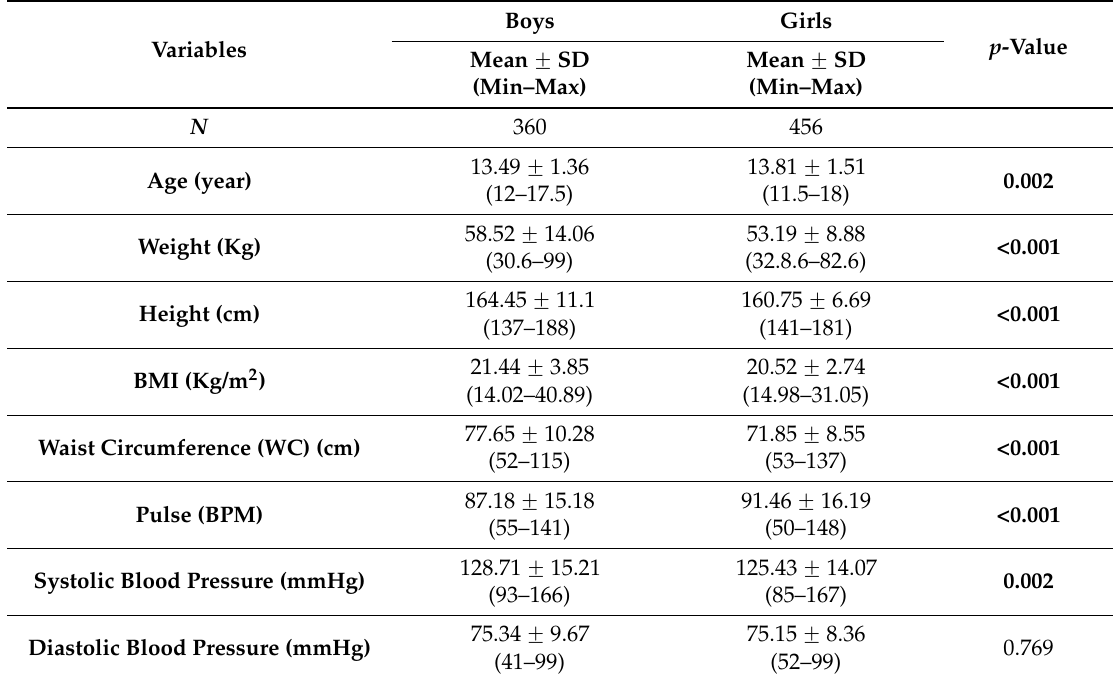
Table 1. Descriptive characteristics of